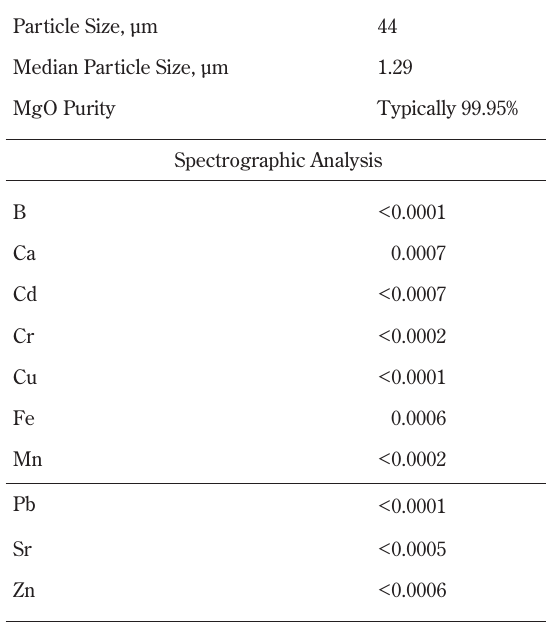
Table 4 General properties of MgO